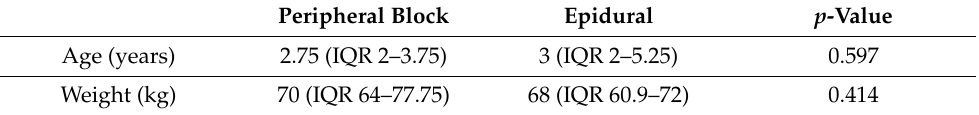
Table 1. Median age and bodyweight did not differ between groups. IQR: interquartile range.